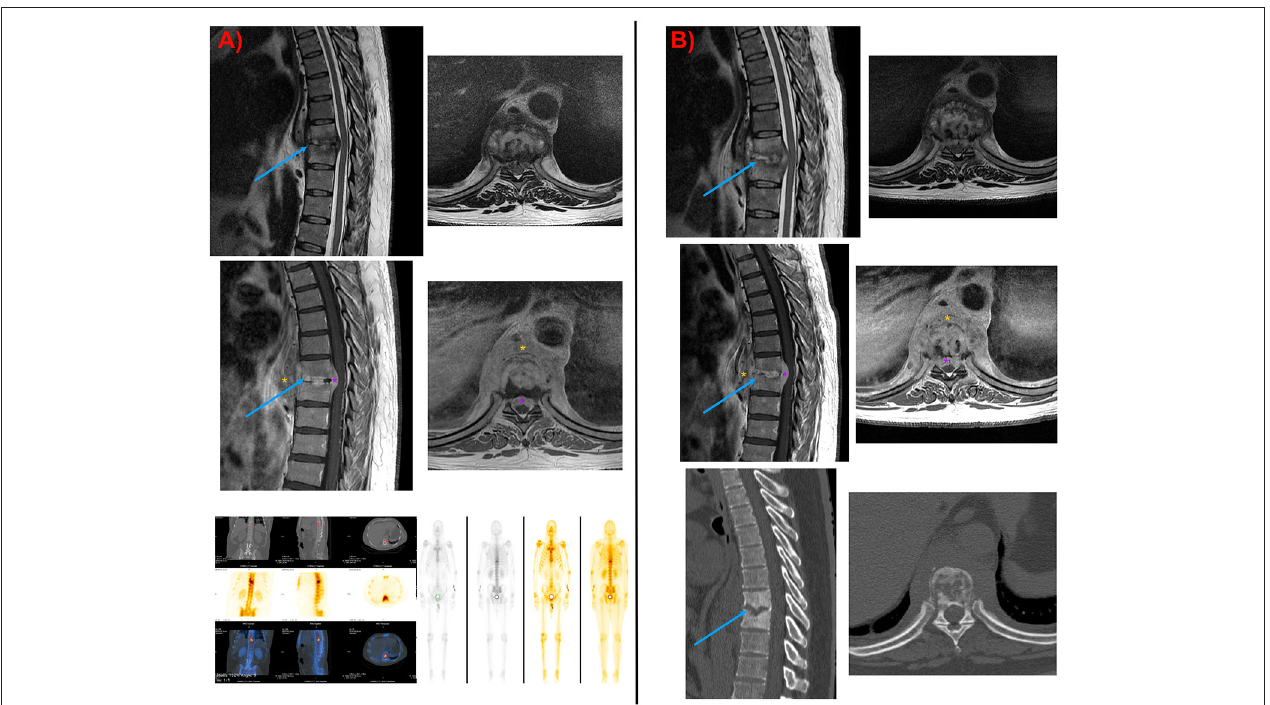
FIGURE 1 | (A) Initial MRI image. Note the important prevertebral mass with disc and adjacent bone involvement typical of fungal spondylodiscitis. In addition, an epidural mass was seen with spinal cord compression. Positive SPECT-TC and gamma scan showing a pathological uptake where spondylodiscitis was suspected. (B) MRI and CT were taken a few days before surgery. The results reaffirmed the necessity of surgery in this case, given the inefficiency of medical treatment. Note the worsening of the Kyphosis curve, the damaged bone, and the epidural mass. Blue arrow, spondylodiscitis destruction; Orange asterisk, prevertebral mass infection; Purple asterisk, epidural mass